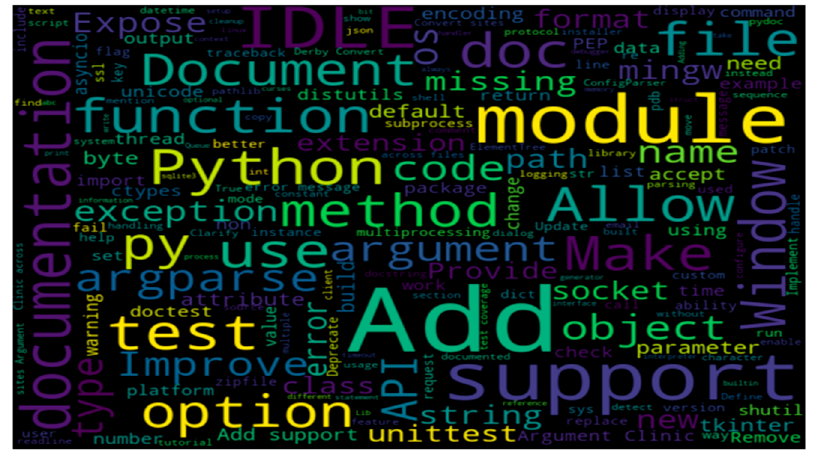
Figure 6. Word cloud of “Crash” error.